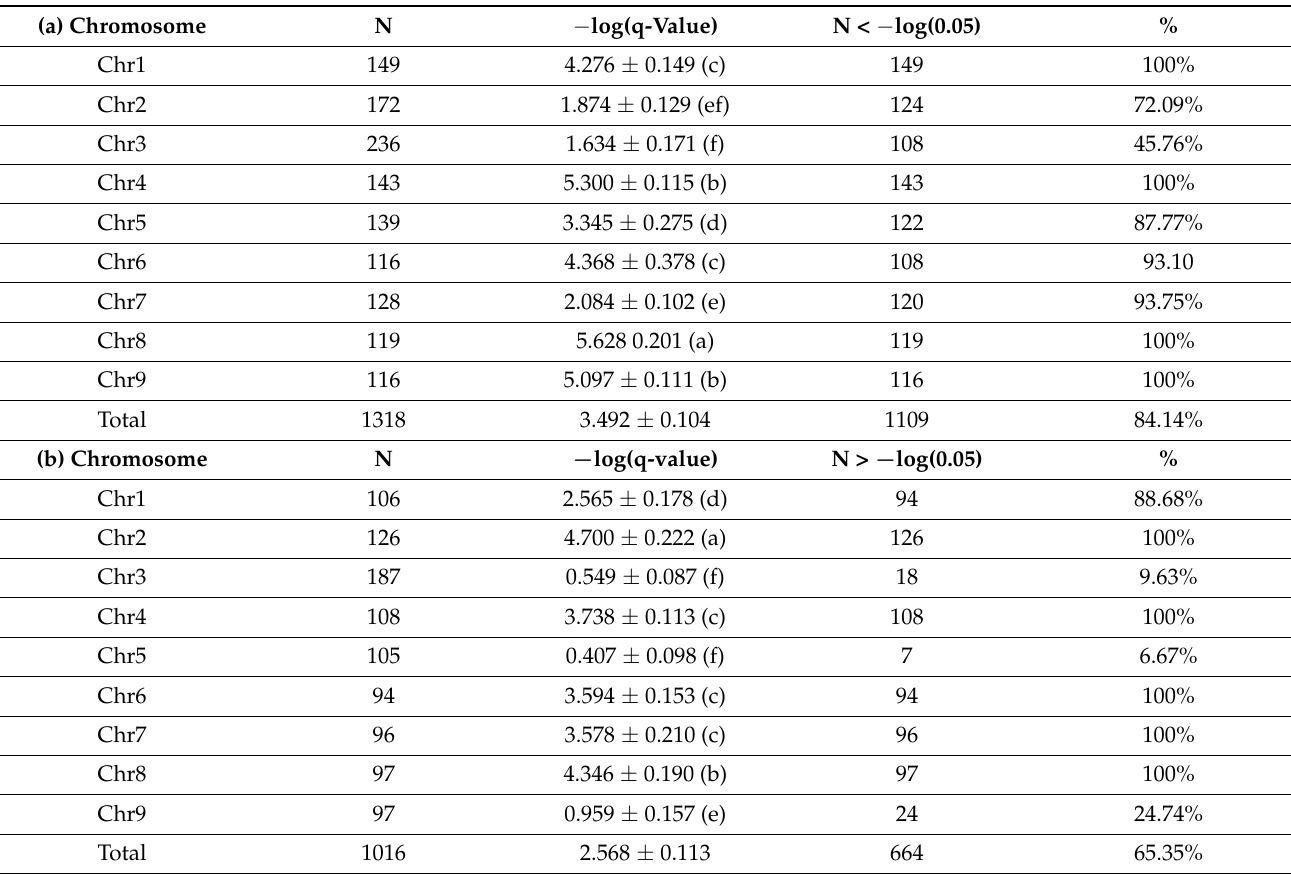
Table 4. Deviation to the tetrasomic gametic segregation model in ( a ) Swingle citrumelo and ( b ) Volkamer lemon